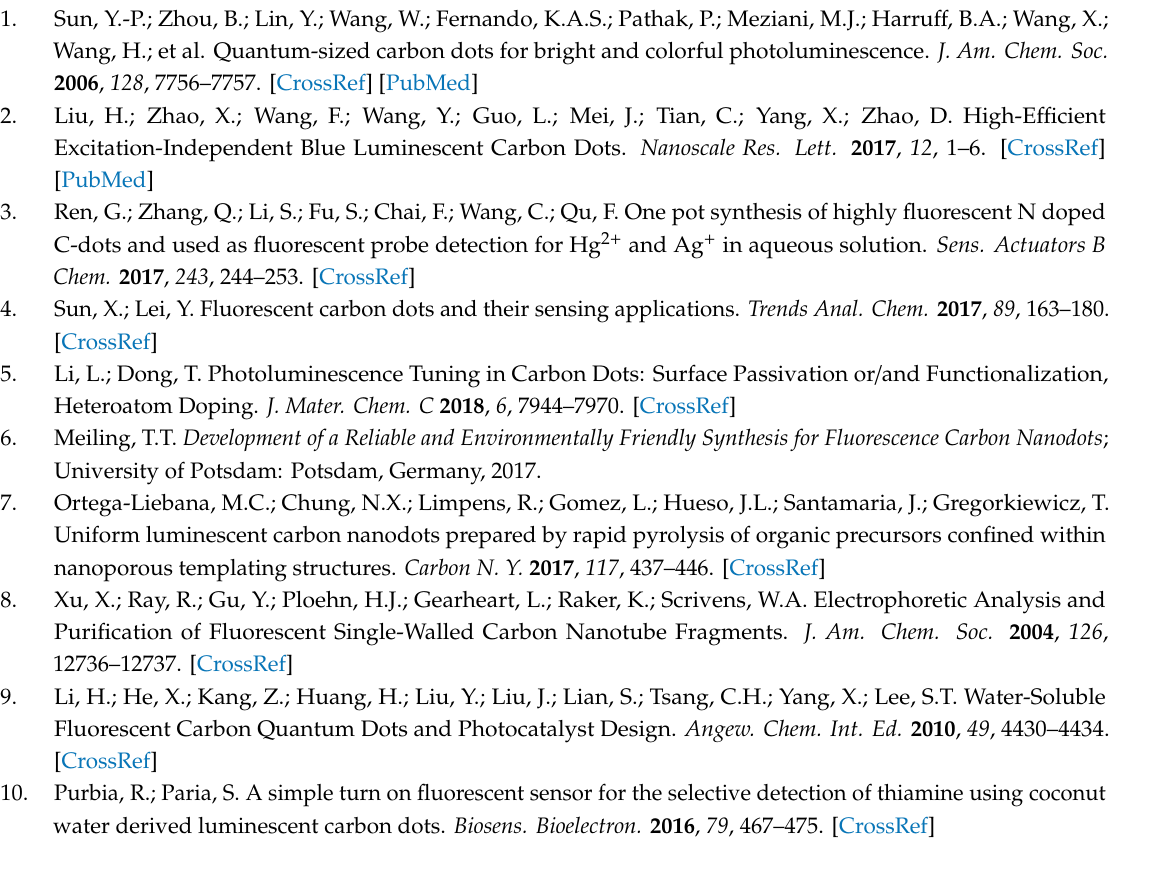
Figure S1: Fundamental understanding of the N–CDs formation pathway, Figure S2: PL intensity as a function of (a) illumination time irradiated with UV light (365 nm) and (b) NaCl concentration, (c) KCl concentration and (d) temperatures, Figure S3: (a) Digital images showing N–CDs in ambient light and N–CDs and water under UV-lamp after six months at room temperature and (b) e ff ect of storage time on the fluorescence intensity of the N–CDs (0–6 months) at 25 ◦ C, Figure S4: The e ff ect of (a) sensing time and (b) pH value on the relative fluorescence quenching of N–CDs before and after addition of 50 µ M of copper ions, Figure S5: DLS size distribution of N–CDs after the addition of 700 µ M Cu (II), Figure S6: Zeta potential of N–CDs after the addition of 700 µ M Cu (II), Figure S7: PL spectra of N–CDs solution and N–CDs-PVA film showing (a) excitation and (b) emission maxima, Figure S8: FTIR spectra of the as-synthesized N–CDs and PVA / N–CDs film, Figure S9: Photostability of N–CDs-PVA composite film, Table S1: A summary of di ff erent starting materials used for synthesis of CDs, Table S2: Optimization of LPEI concentration for the production of N–CDs, Table S3: Optimization of synthesis conditions for the production of N–CDs, Table S4: Elemental compositions of the undoped and N–CDs, Table S5: Quantum yield calculation of PVA / N–CDs